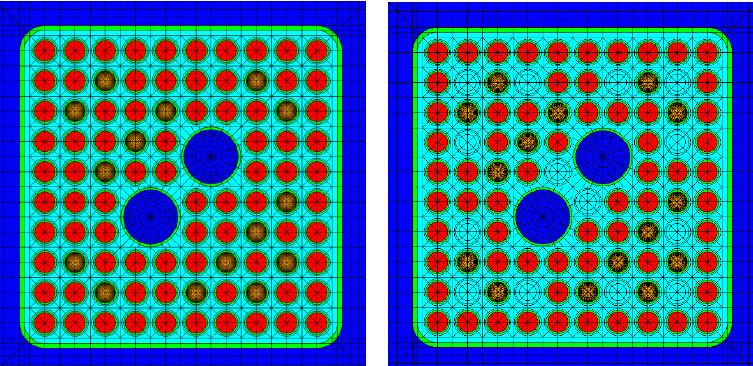
Figure 3. Polaris models of dominant ( left ) and vanished ( right ) FA layers for the cross-section preparation.